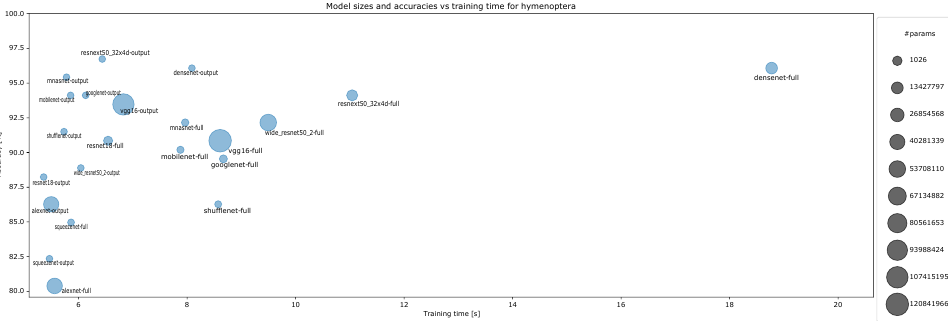
Figure A19. Accuracy vs, training time and model size for MNIST for one-episode training.